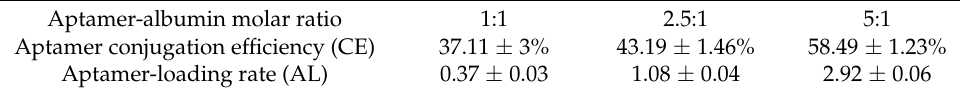
Figure 4. The bindings of BSA, polyA, free PD-L1 aptamer, or BSA-Apt to PDL1-positive CT26 cells. CT26 cells (2 × 10 5 ) were incubated with 60 pmol of FAM-labeled BSA (green), polyA (purple), free PD-L1 aptamer (blue), or BSA-Apt (red), respectively. The cells were washed with PBS and analyzed by flow cytometry. To further investigate whether BSA-Apt could bind to CT26 colon cancer cells, con- focal microscopy was used to study the CT26 cells treated by FAM-labeled PD-L1 ap- tamer, BSA-Apt, or polyA that served as a control DNA sequence. As shown in Figure 5, both BSA-Apt and the free PD-L1 aptamer generated strong fluorescent signals, while